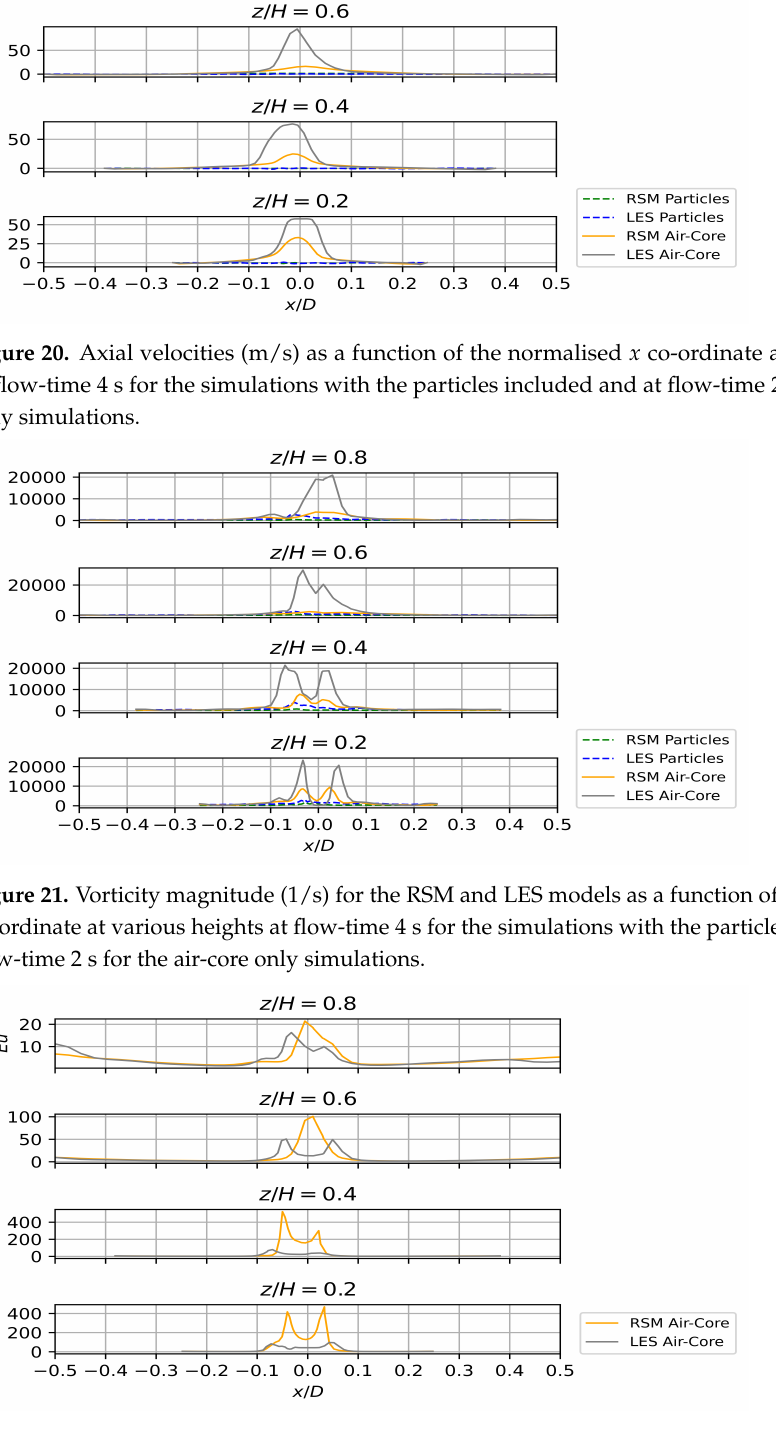
Figure 22. Euler Number for the air-core models as a function of the normalised x co-ordinate at various heights at flow-time 2